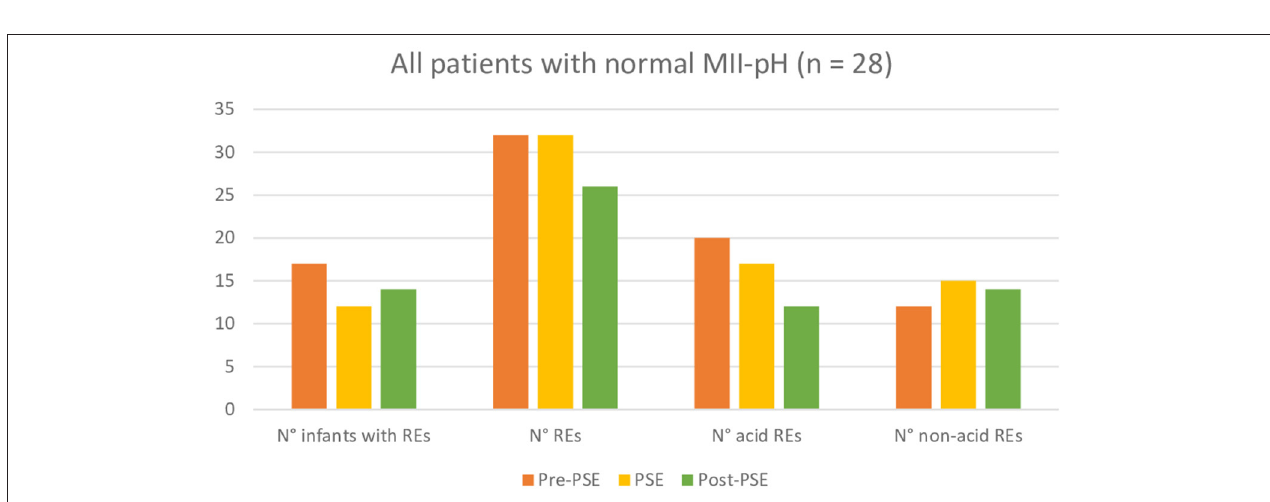
FIGURE 4 | Comparison of reflux episodes between before, during, and after the Prolonged Slow Expiration (PSE) treatment in the group with normal